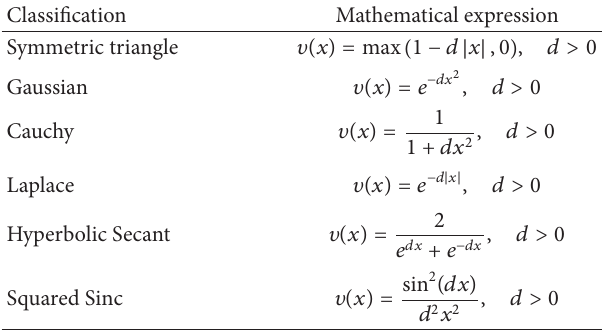
Table 1: Reference functions. Classification Mathematical expression